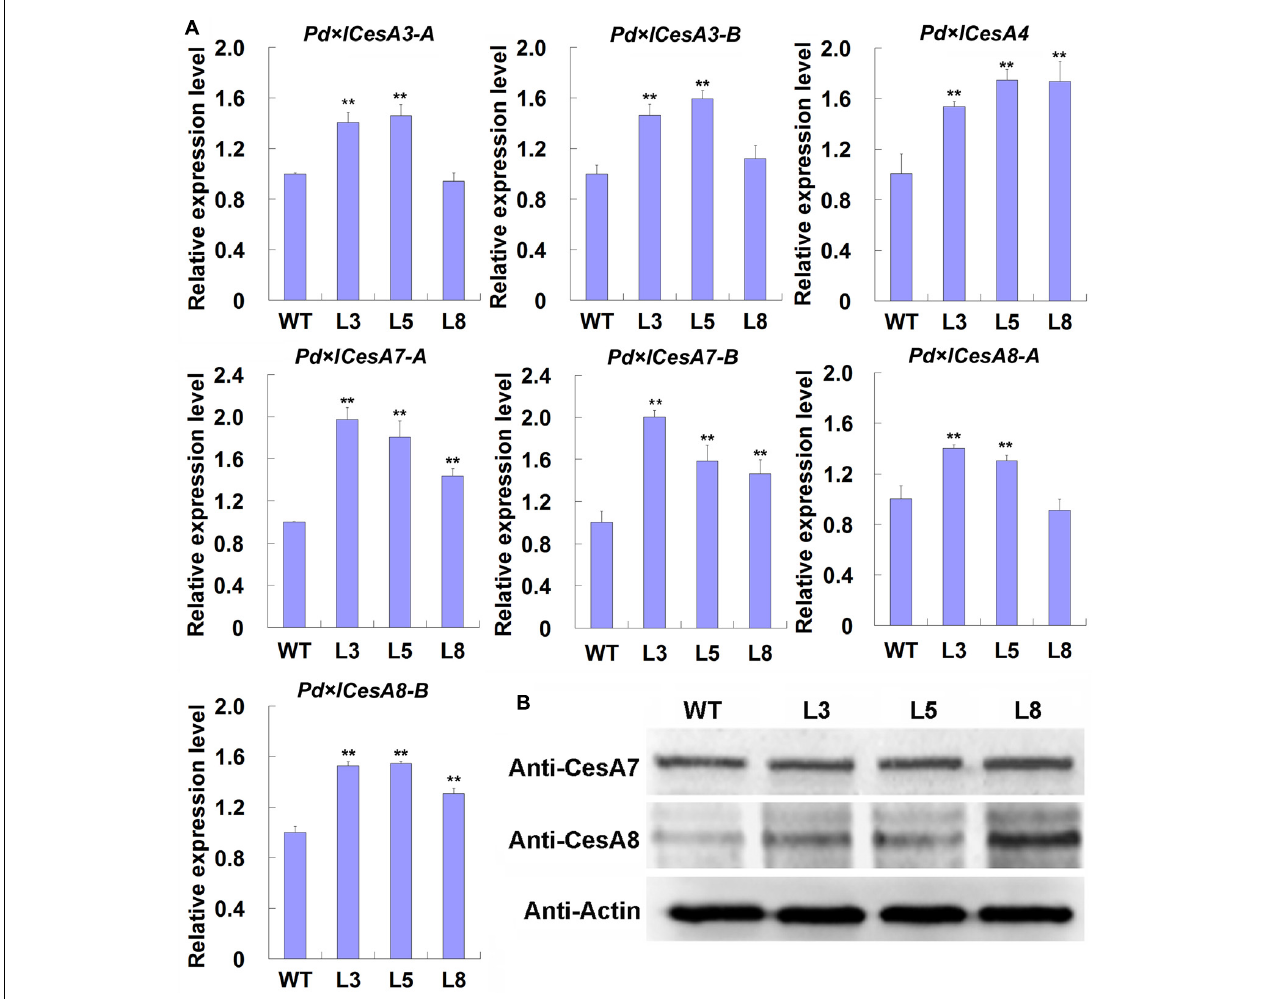
FIGURE 5 | Expression analyses of CesAs in the TW xylem of wild type (WT) and transgenic Shanxin yang plants. (A) Transcription analyses of CesAs. Gene expression value in WT plants was set to 1. Data were means ± SD ( n = 6) of three independent biological replicates with three technical replicates each. ** indicates a significant difference in comparison to WT at P < 0.01. (B) Western blotting analyses of proteins recognized by anti-CesA7 and anti-CesA8 antibodies in the TW xylem of WT and transgenic lines. M, protein molecular weight marker; WT, wide type; L3, L5, and L8, different transgenic lines overexpressing PtiCYP85A3 . Anti-CesA7, AtCesA7 polyclonal antibody; Anti-CesA8, AtCesA8 polyclonal antibody; Anti-Actin, plant actin antibody. Gene Potri ID numbers were provided in Supplementary Table S1